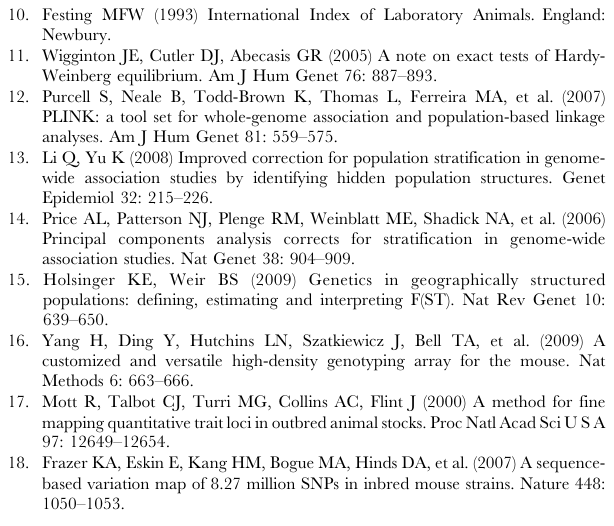
Table S2 Sequences variants found in